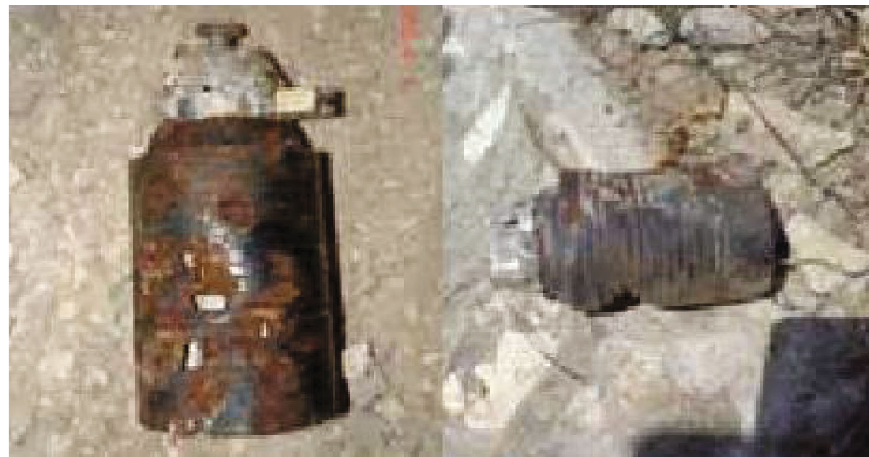
Figure 2: The unexploded submunition whose ribbon falls o ff